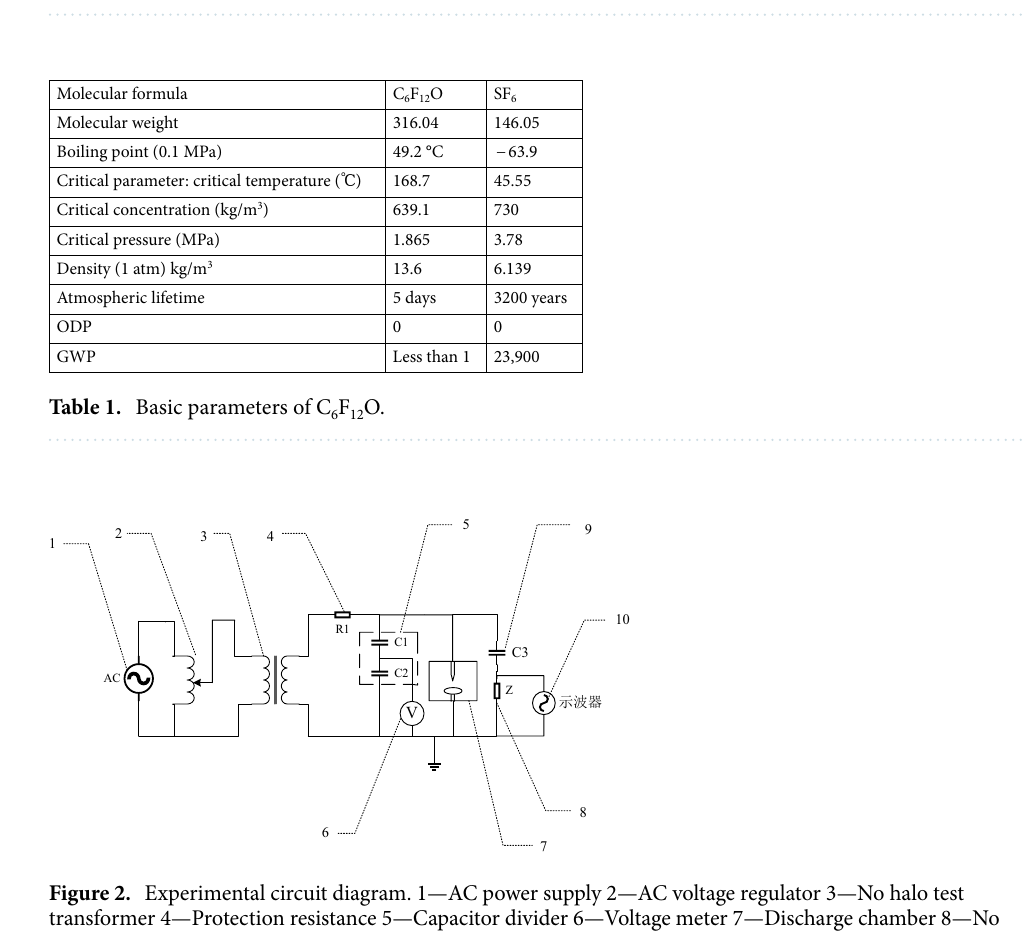
Figure 1. Molecular formula of C 6 F 12 O.